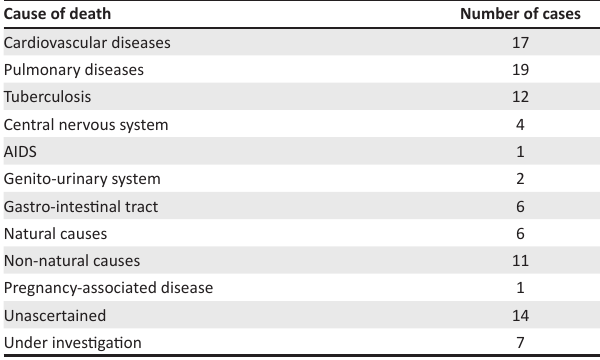
TABLE 3: Causes of death.